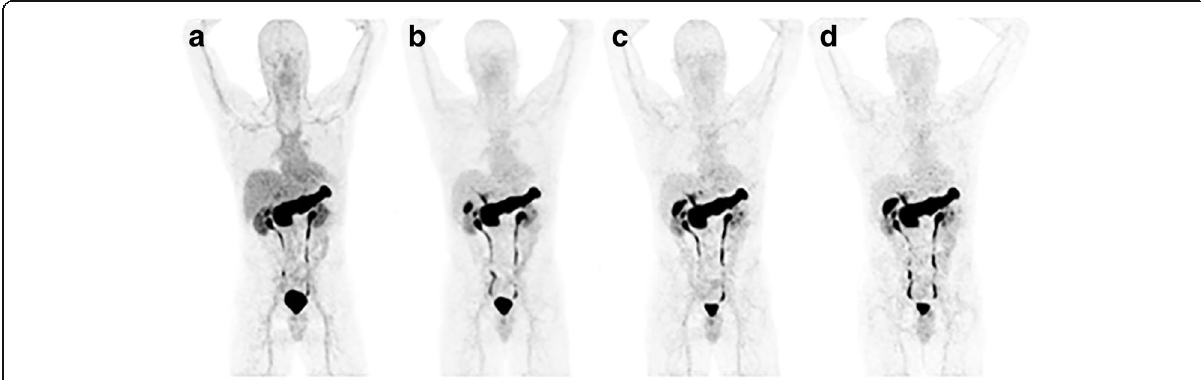
Fig. 1 Maximum intensity projections acquired 10, 45, 70 and 100 min after 68 Ga-NODAGA-MJ9 injection ( a – d , respectively) in a 56-year-old patient with biochemical relapse of prostate cancer (patient #5). The typical 68 Ga-NODAGA-MJ9 biodistribution is observed, including visualisation of the urinary system, as well as fast and prominent uptake by the pancreas and the biliary tract